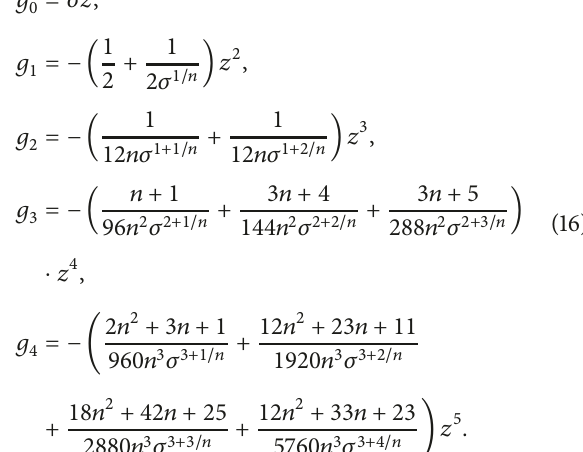
Figure 1: Flux distribution for 𝑘(𝑧) = 𝑧, ℎ(𝑧) = 1 − 𝑧, 𝛼 = 0.1, 𝑛 = 1.0, 5.0, 10.0.